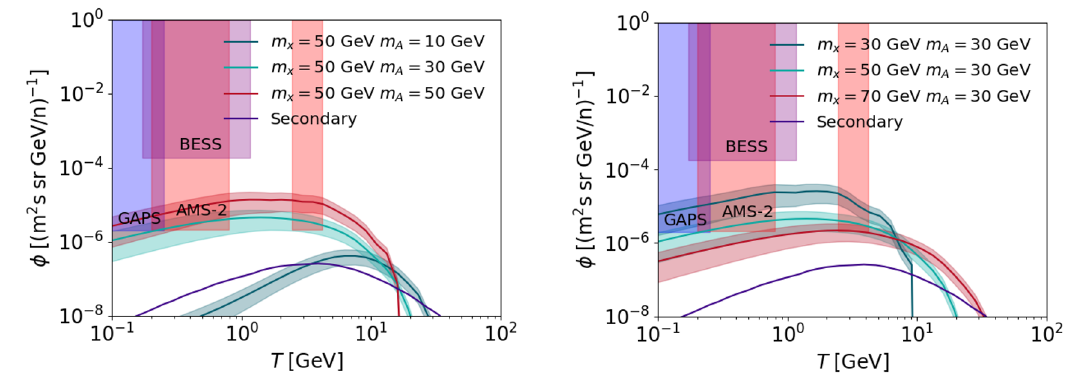
Figure 8. The dependence of expected antideuteron (cid:13)ux for various choices of m A 0 (left) and m (cid:31) (right). As shown, the expected (cid:13)ux at low energies in particular is quite sensitive to the mass di(cid:11)erence between these two particles, and the antideuteron injection is much less e(cid:14)cient for low dark photon